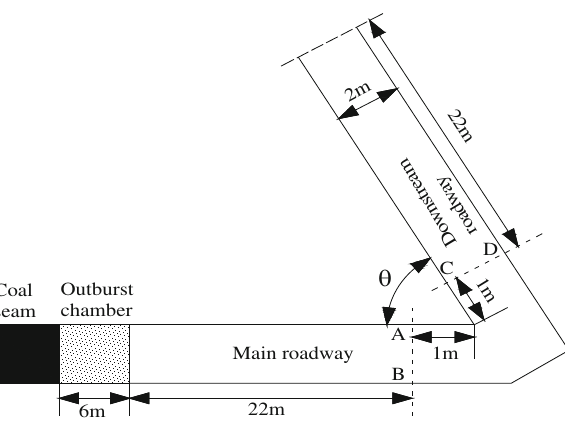
Fig. 5 Geometry of corner